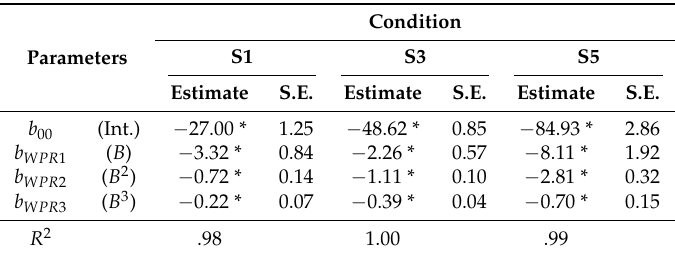
Table 2. Estimated parameters for the sequential regression approach with unstandardized regression weights.